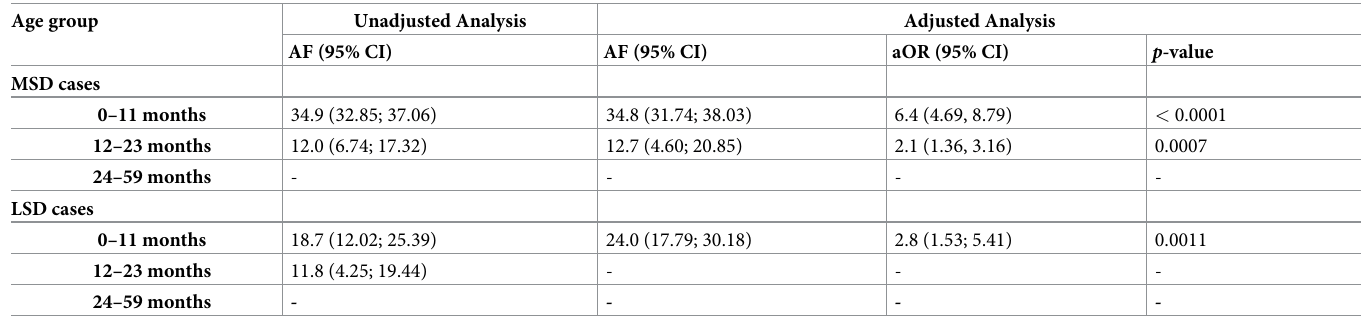
Table 2. Attributable fractions (AF) of rotavirus among children 0–59 months with MSD and LSD cases. Age